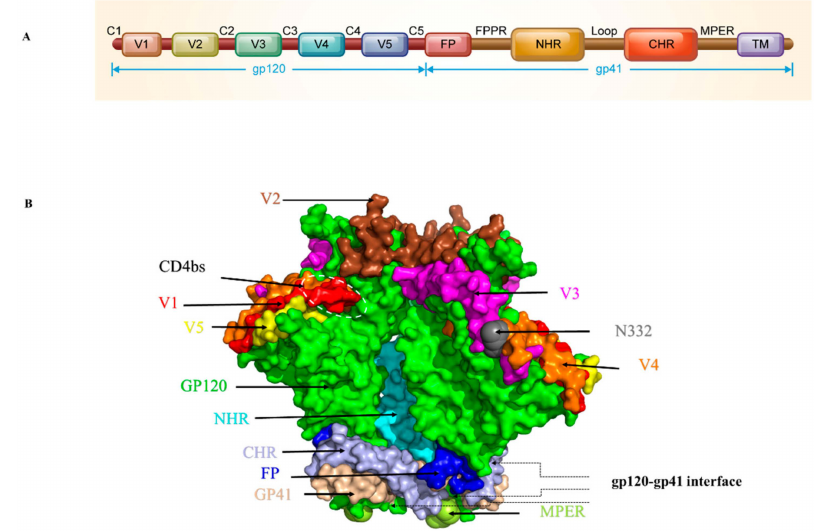
Figure 2. Ectodomain structure of HIV-1 Env trimer. ( A ) Schematic diagram of HIV-1 gp120 and gp41. ( B ) Side view of the Env trimer. Gp120 is colored in green with the V1, V2, V3, V4, and V5 regions colored in red, brown, purple, orange and yellow, respectively. CD4bs is marked with a white dotted frame. Gp41 is colored in light pink with the fusion peptide (FP), N-terminal heptad repeats (NHR), C-terminal heptad repeats (CHR) and membrane-proximal external region (MPER) regions colored in blue, cycan, bright gray and cycan-blue, respectively. The images were generated with the software PyMOL according to the PDB ID: